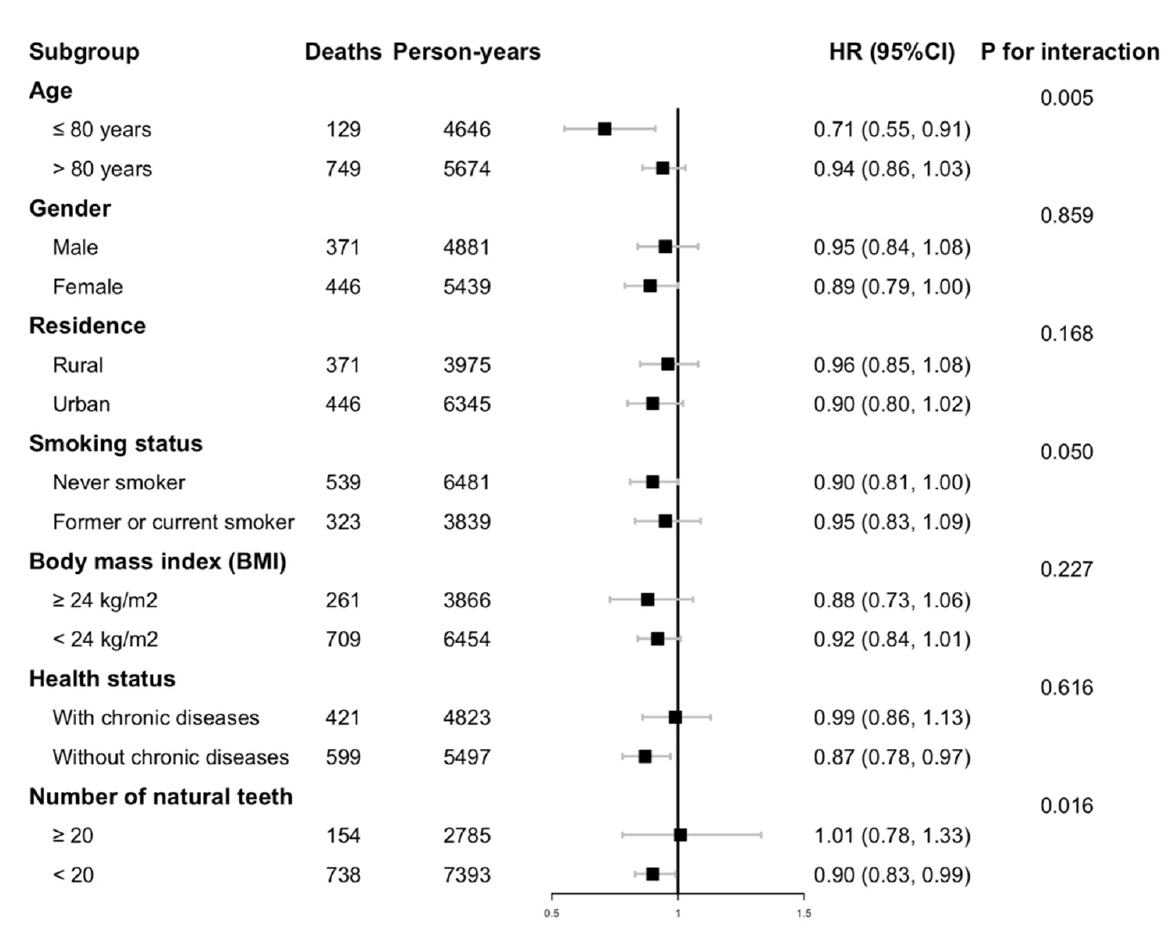
Figure 1. Hazard Ratios (95% CI) of regular intake of mushrooms and algae for mortality, stratified by selected characteristics. Multivariable models were adjusted for age, gender, ethnicity, level of education, type of residence, marital status, income level, smoking status, alcohol consumption, regular exercise, BMI, and major food group consumption (including fresh fruits, fresh vegetables, meat and poultry, fish and aquatic products, preserved vegetables, nuts, legumes, and sugar and sweets). Abbreviation: HR, Hazard Ratio; CI, Confidence Interval; kg, kilogram; m, meter.